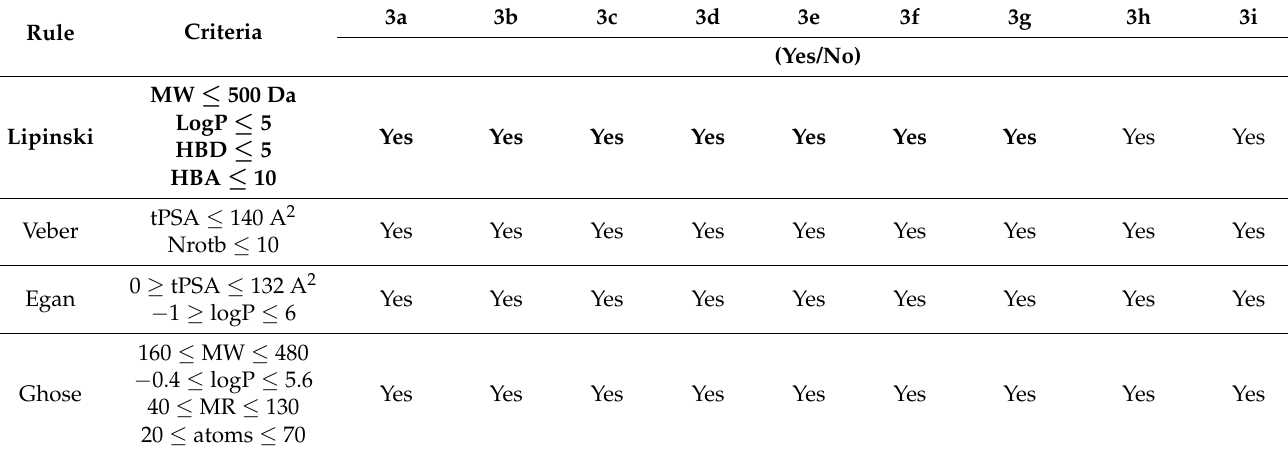
Table 2. Summary of the most important literature criteria considered in the assessment of bioavailability of new compounds. Rule